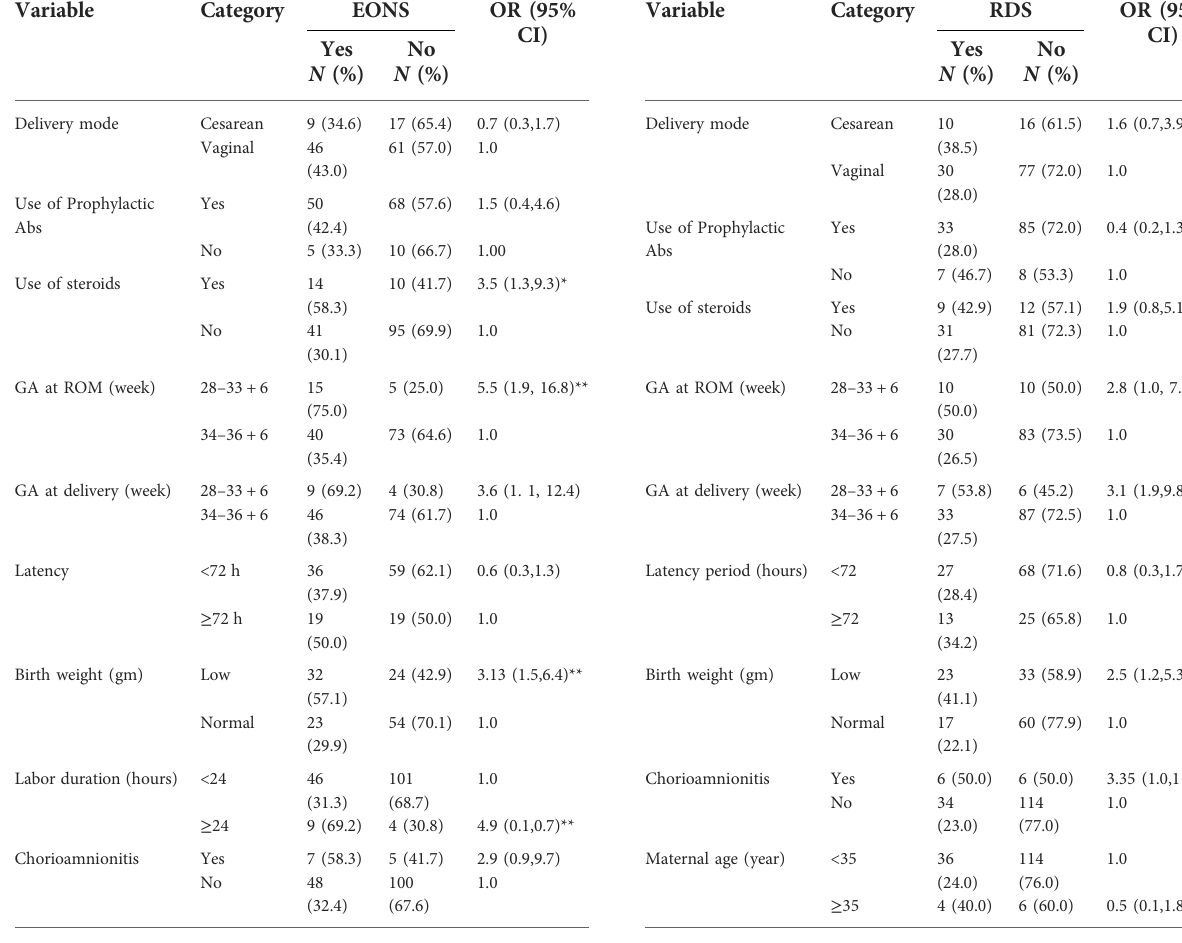
TABLE 4 Factors determining the development of EONS among pregnant women with preterm premature rupture of membrane. Variable